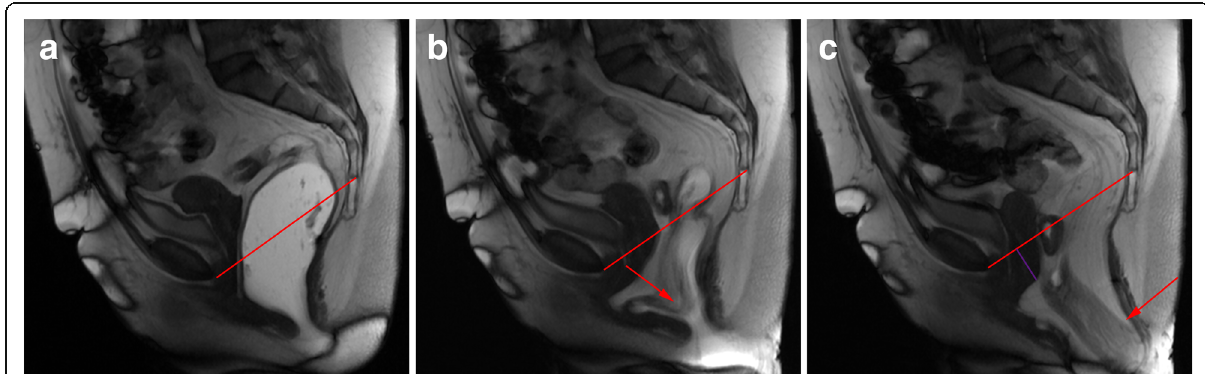
Fig. 14 Rectal prolapse with a moderate uterine prolapse. ( a , b , c ) Sagittal midline TrueFISP images at the beginning ( a ), middle ( b ), and end ( c ) of the evacuation phase demonstrating a rectal intussusception extending beyond the anal sphincter (red arrows). Note also that it is accompanied by a moderate uterine prolapse and a peritoneocele, both aggravating along the different times of the evacuation phase. Red line : PCL; purple line : extent of the uterine